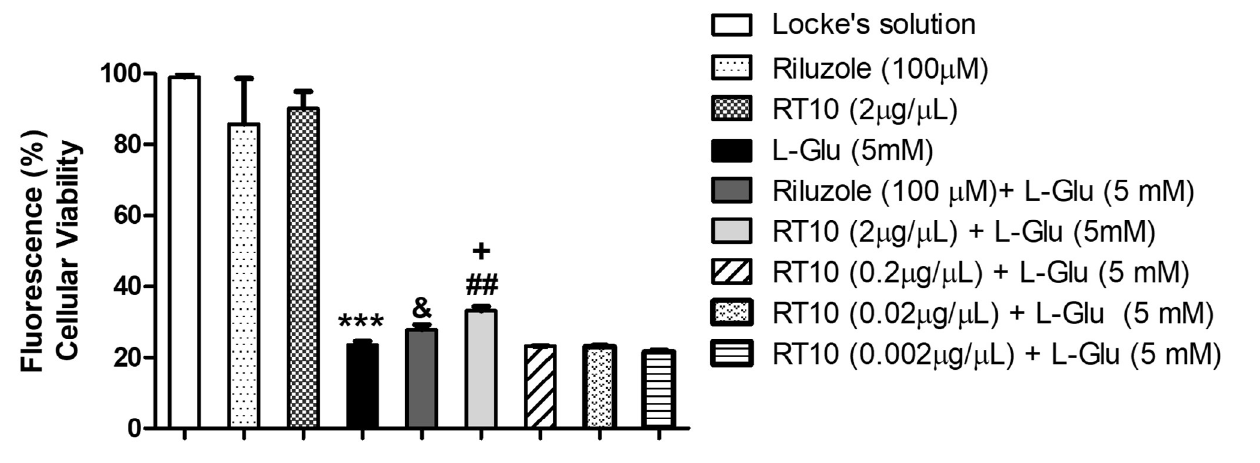
Figure 2. Cellular viability expressed in normalized levels of fluorescence (percent and standard deviation), after 12 hours incubation with L- Glu (5mM) to the cultures. Data is presented as mean ± S.E.M. Treatments with riluzole (100 μM) and RT10 (0.002; 0.02; 0.2 and 2 μg/μL) for 3h, before insults , produced insignificant differences. (***p< 0.001 vs. Locke’s solution group; &p<0.05 and ##p<0.01 vs. L- Glu-5 mM; +p<0.05 vs riluzole+ L- Glu 5 mM). One-way ANOVA followed by Newman-Keuls test